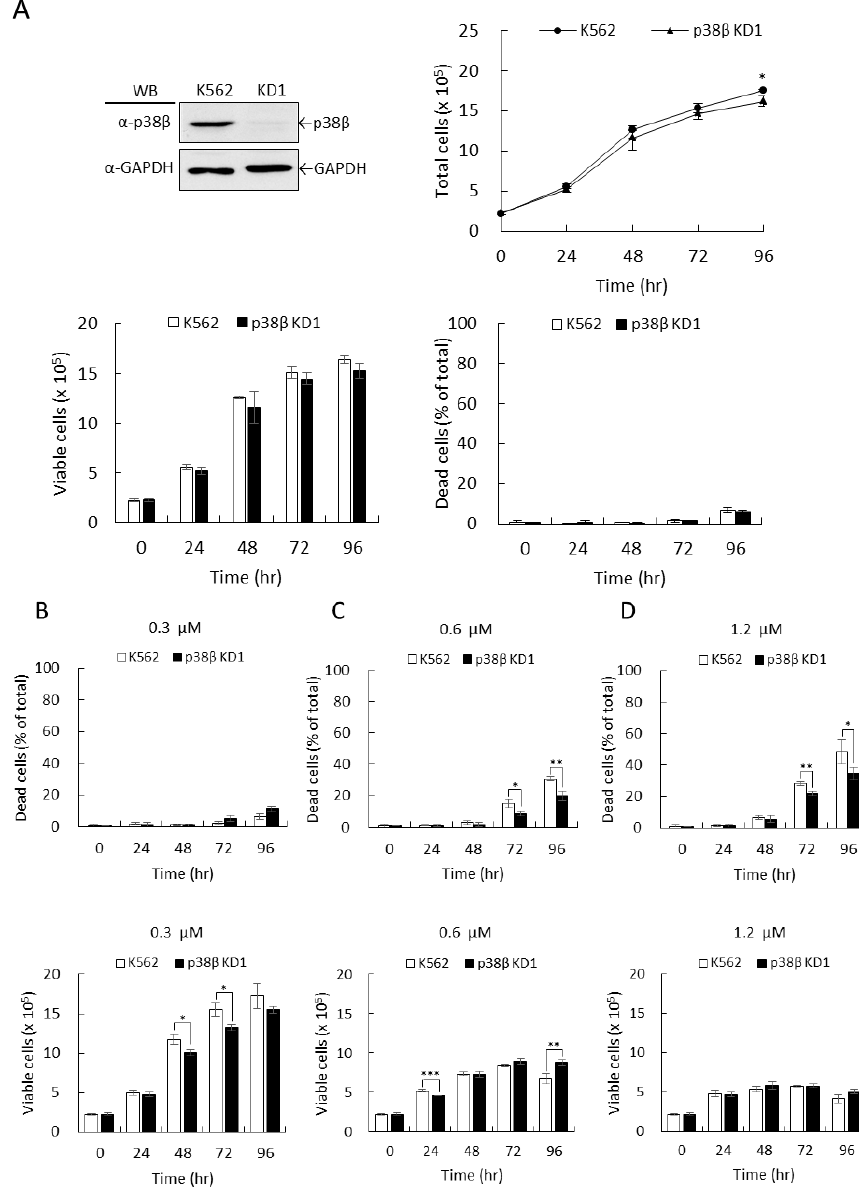
Figure 4. Knockdown of p38 β did not sensitize K562 leukemia cells to the therapeutic effects of imatinib. The transcripts of p38 β were knocked down using specific shRNAs. The protein levels of p38 β were detected by Western blotting ( A ). The cell growth and viability of parental K562 and knockdown KD1 cell clones under normal culturing conditions were examined by trypan blue exclusion using hemocytometer counting under a microscope ( A ). Cells were treated with 0.3 ( B ), 0.6 ( C ), and 1.2 µM ( D ) of imatinib and the cell viability was examined. Deficiency of p38 β did not sensitize K562 cells to the killing effect of imatinib as observed with p38 α deficiency. On the con- trary, p38 β deficiency exhibited a slight but significant resistance to the killing effect of imatinib. All results shown are representatives of three independent experiments. Viable and dead cell numbers are presented as the mean ± SE of three repeats. * p < 0.05, ** p < 0.01, and *** p < 0.005. 2.4. The Cytotoxic Effect of Dasatinib Was Enhanced upon p38 α Knockdown Dasatinib is a second-generation BCR-ABL inhibitor with a higher inhibitory effi- cacy toward the kinase activity of the BCR-ABL oncogene [26] and is widely used to treat CML patients. Dasatinib binds to the active conformation of the kinase domain and also has a high inhibitory efficacy toward other tyrosine kinases, such as Src, and thus renders a higher risk of side effects [9]. We further investigated whether p38 α might affect the killing effect of dasatinib. Dasatinib exerted a significant cytotoxic effect in K562 parental cells with 28% and 58% cell death at 1 nM and 2 nM, respectively (Figure 5A,B, 96 h, upper). The p38 α -knockdown cells were much more sensitive to dasatinib. The cell death events were 57% and 93% at 1 and 2 nM, respectively (Figure 5A,B, 96 h, upper), which were almost double the death events in K562 parental cells. The total viable cells also re- flected the profound increase in cellular responses to the killing effect of dasatinib (Figure 5A,B, bottom). Taken together, p38 α deficiency greatly enhances the efficacy of two im- portant, clinically used therapeutic TKIs — imatinib and dasatinib — in BCR-ABL-positive leukemia K562 cells. These results indicate a potential novel strategy in providing a more effective and safer treatment for CML by combining TKIs (e.g., imatinib or dasatinib) and specific p38 α inhibition.